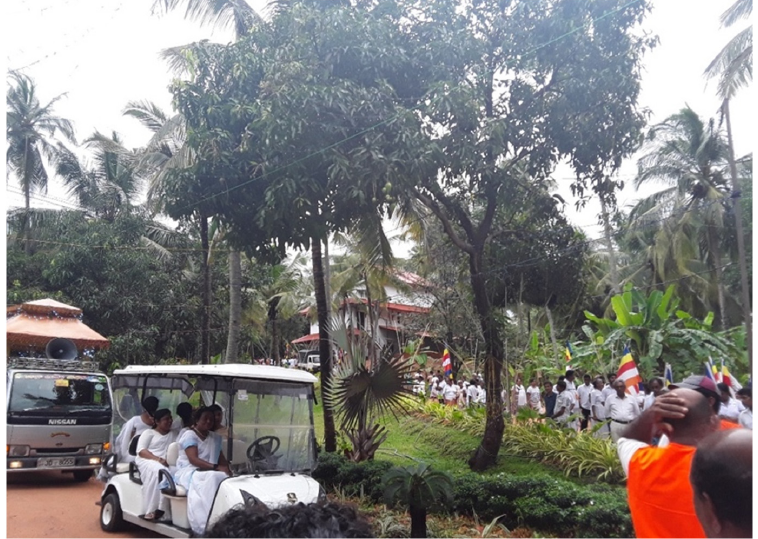
Figure 1. People prepare for the Katina procession. Photo by author. 19 October 2019, Umandawa Monastery, Kurunegala.